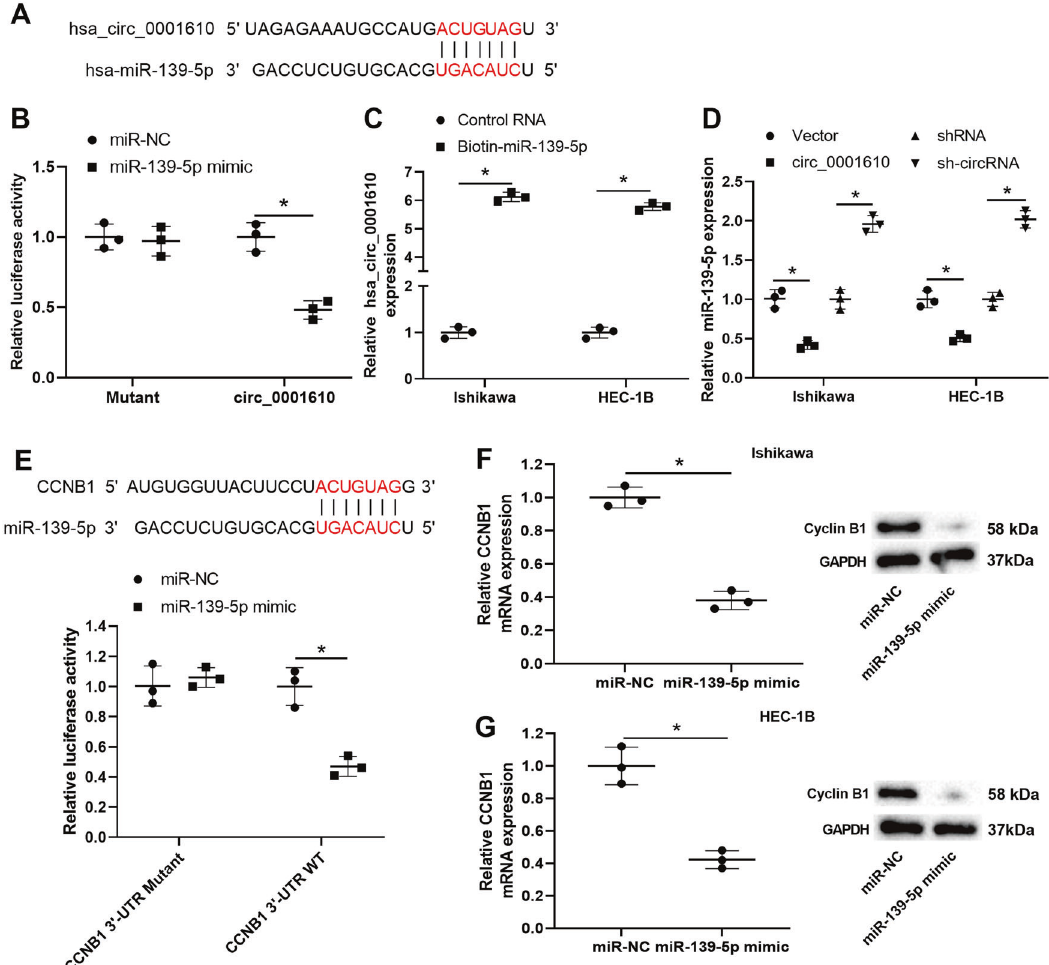
Fig. 4 The interplay between hsa_circ_0001610, microRNA (miR)-139-5p, and cyclin B1. A The potential binding sites between hsa_circ_0001610 and miR-139-5p. B Dual-luciferase reporter assay using HEK-293T cells co-transfected with pmirGLO-circ_0001610 vector/ pmirGLO-mutant-circ_0001610 vector and miR-139-5p mimic/the negative control of miR-139-5p mimic (miR-NC). C qRT-PCR analysis of hsa_circ_0001610 level in the streptavidin captured fractions from the Ishikawa and HEC-1B cell lysates after incubation with biotinylated miR- 139-5p (biotin-miR-139-5p) or control RNA. D qRT-PCR analysis of miR-139-5p in the Ishikawa and HEC-1B cells after transfection with circ_0001610/the negative control of circ_0001610 (vector)/sh-circRNA/shRNA. E Upper: the potential binding sites between CCNB1 (the encoding gene of cyclin B1) and miR-139-5p. Below: dual-luciferase reporter assay using HEK-293T cells co-transfected with pmirGLO-CCNB1 3 ′ -UTR mutant vector/ pmirGLO-CCNB1 3 ′ -UTR wild type (WT) vector and miR-139-5p mimic/ miR-NC. The mRNA and protein levels of cyclin B1 were measured in F Ishikawa and G HEC-1B cells after transfection with miR-139-5p mimic/miR-NC. * p <